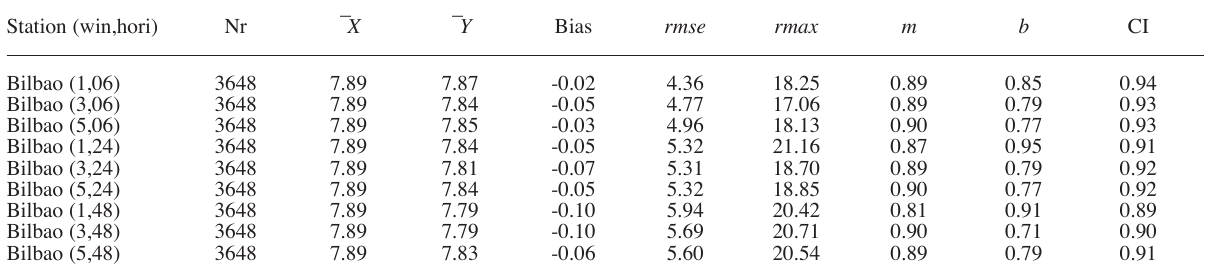
T ABLE 2. – Statistical comparison of measured and simulated residuals after applying the window data assimilation scheme, where win is the length of the data window in days, hori is the forecast horizon, Nr is the number of records, ⎯ X is the mean value of the measured time series, ⎯ Y is the mean value of the simulated time series after the assimilation, BIAS is the difference ⎯ Y- ⎯ X , rmse is the Root Mean Square Error, rmax is the maximum error, m and b are the slope and the interception of the linear fit and CI is the Correlation Index. Station